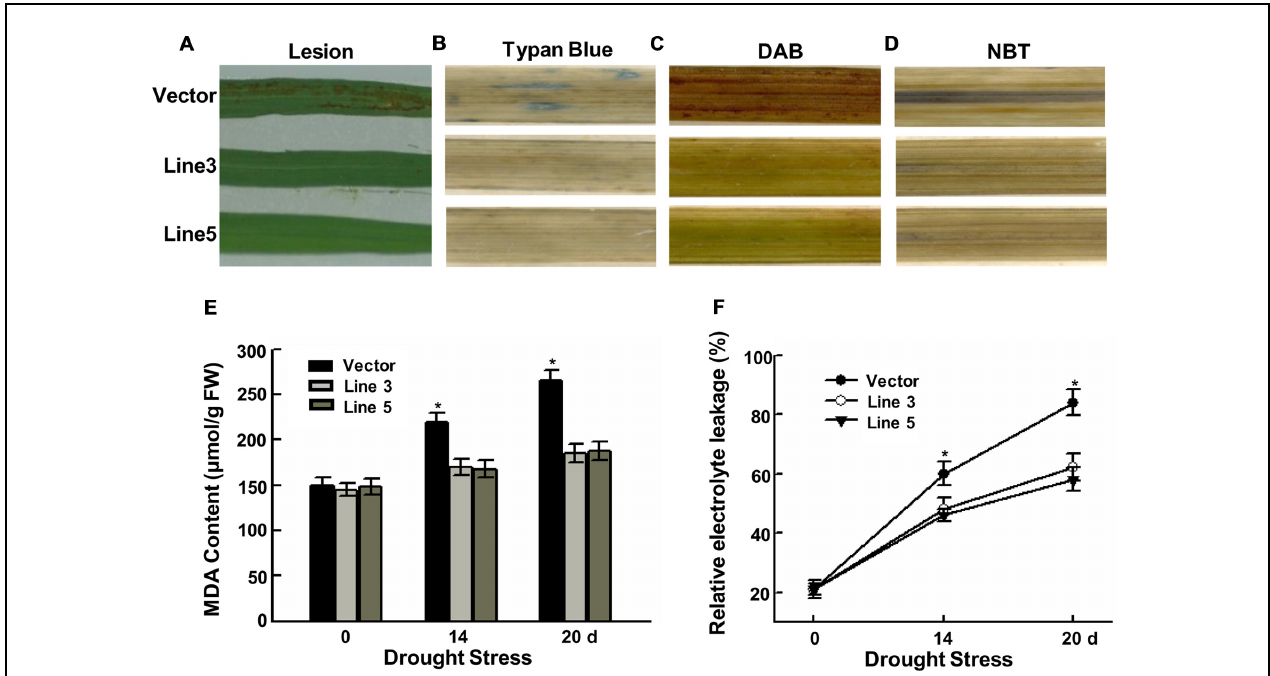
FIGURE 2 | Decreased the ROS damage in transgenic rice. Phenotype of brownish lesions (A) , Typan blue staining (B) , DAB staining (C) and NBT staining (D) after 14 days drought stress. (E) MDA content in the leaves of control and transgenic plants after 0, 14, and 20 days drought stress. Values are the mean ± SE of three independent experiments ( ∗ P < 0.05). FW, Fresh weight. (F) Relative electrolyte leakage in the leaves of control and transgenic plants after 0, 14, and 20 days drought stress. Values are the mean ± SE of three independent experiments ( ∗ P <